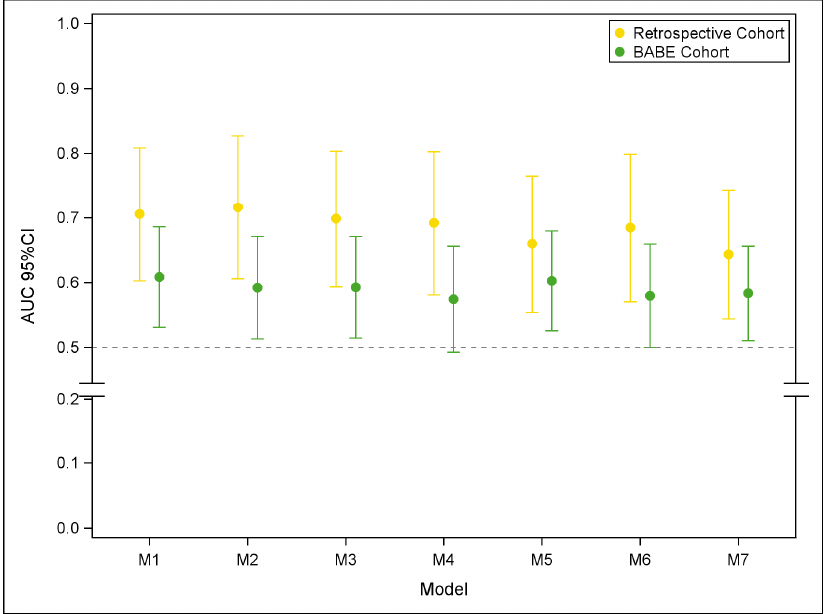
Figure 3. Performance of the 7-miRNA-based signatures (M1-M7) in the Retrospective and BABE Cohorts. Vertical bars representing 95% confidence interval of AUC values.